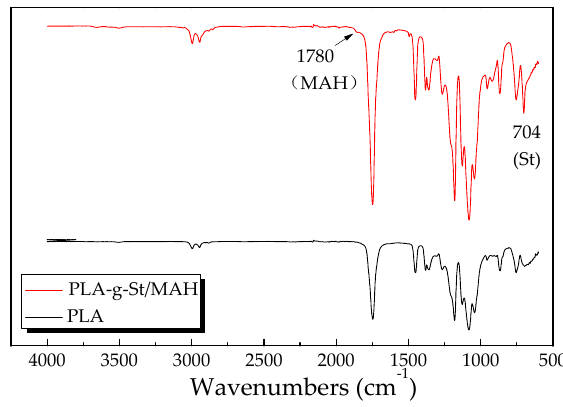
Figure 1. The FT-IR spectrum of PLA and PLA- g -St/MAH.